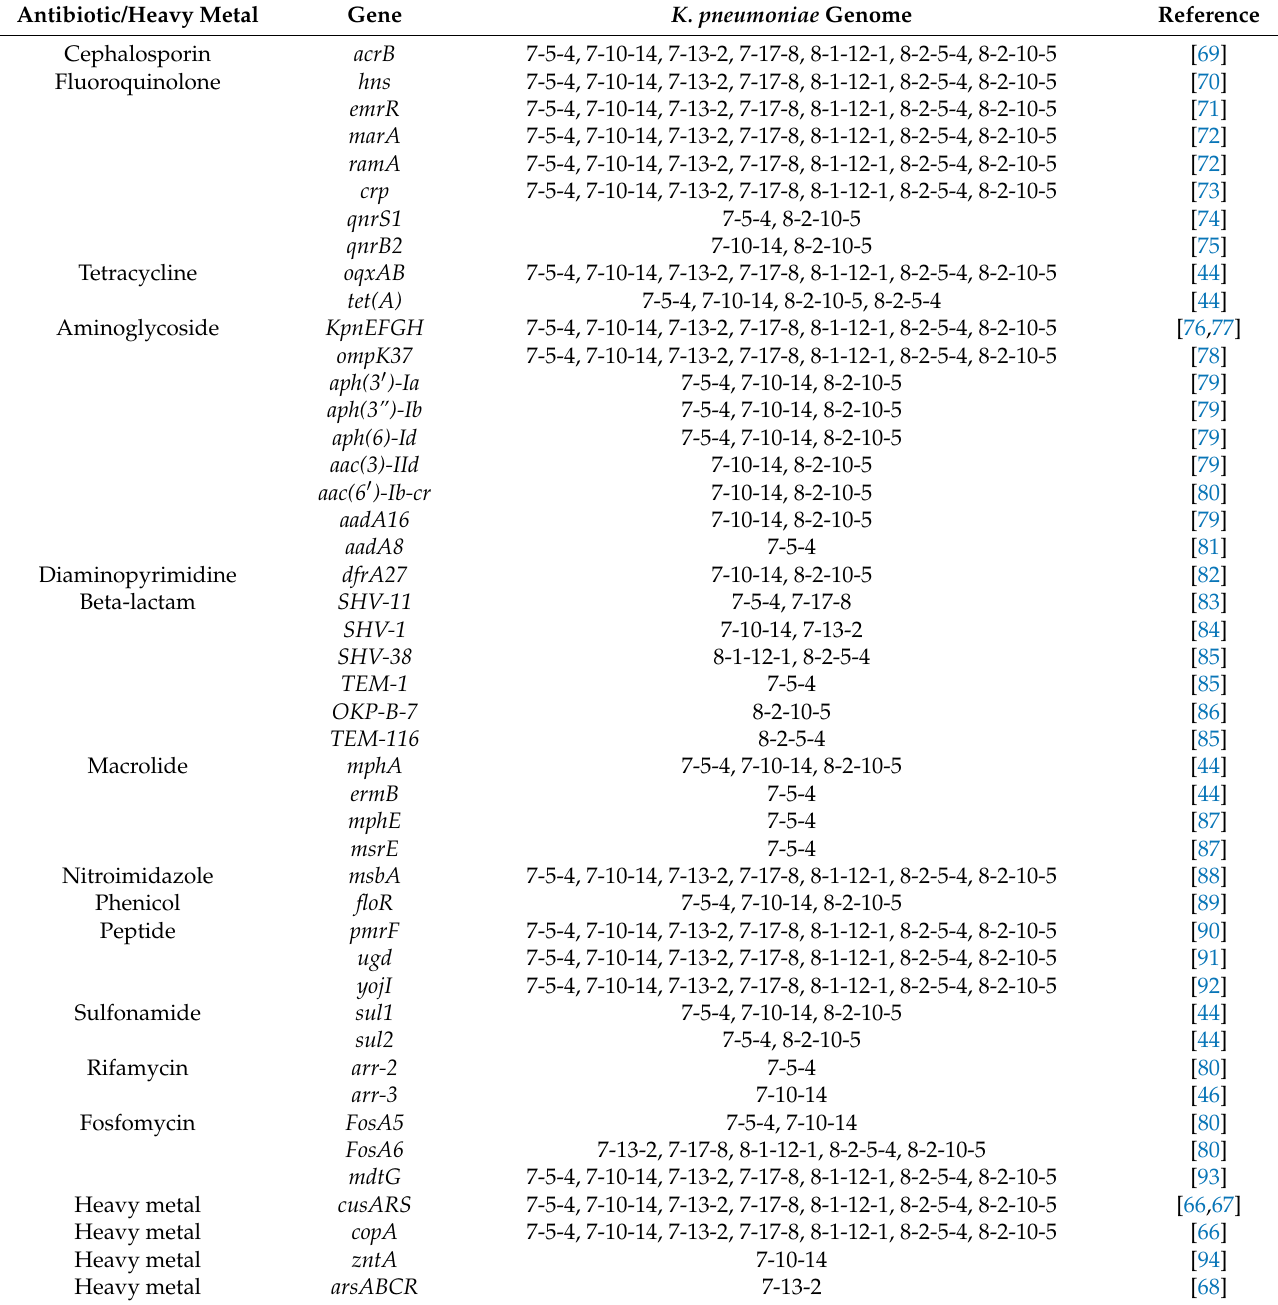
Table 3. The antibiotic and heavy metal resistance-related genes identified in the K. pneumoniae